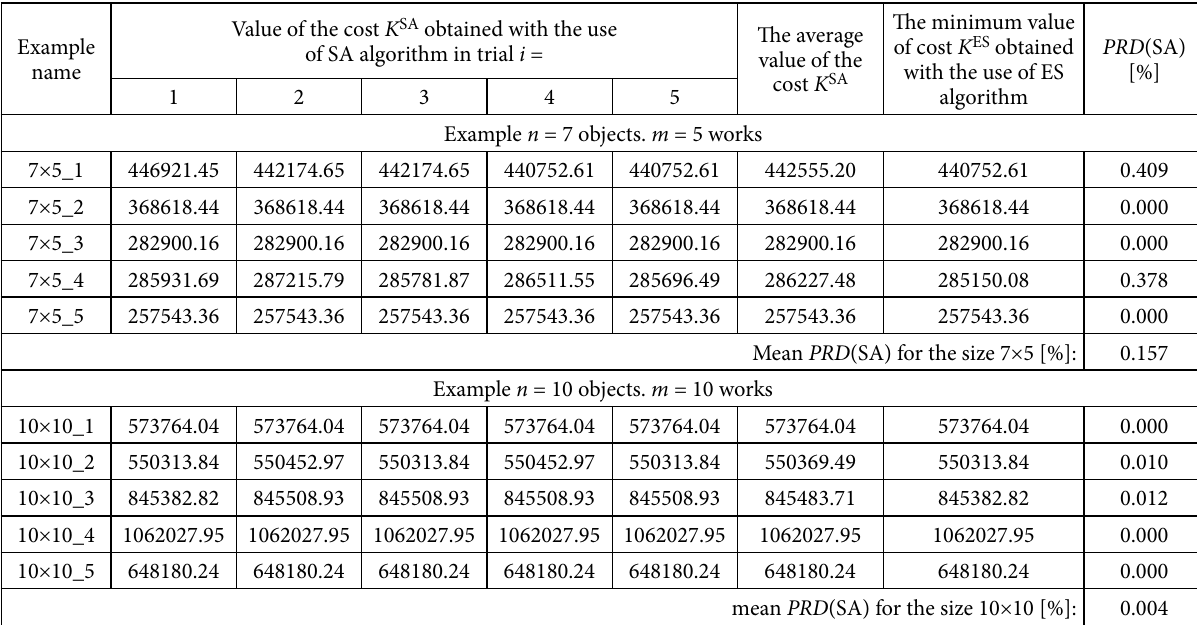
Table 1. Outcomes of the verification of the results obtained with the use of the SA algorithm